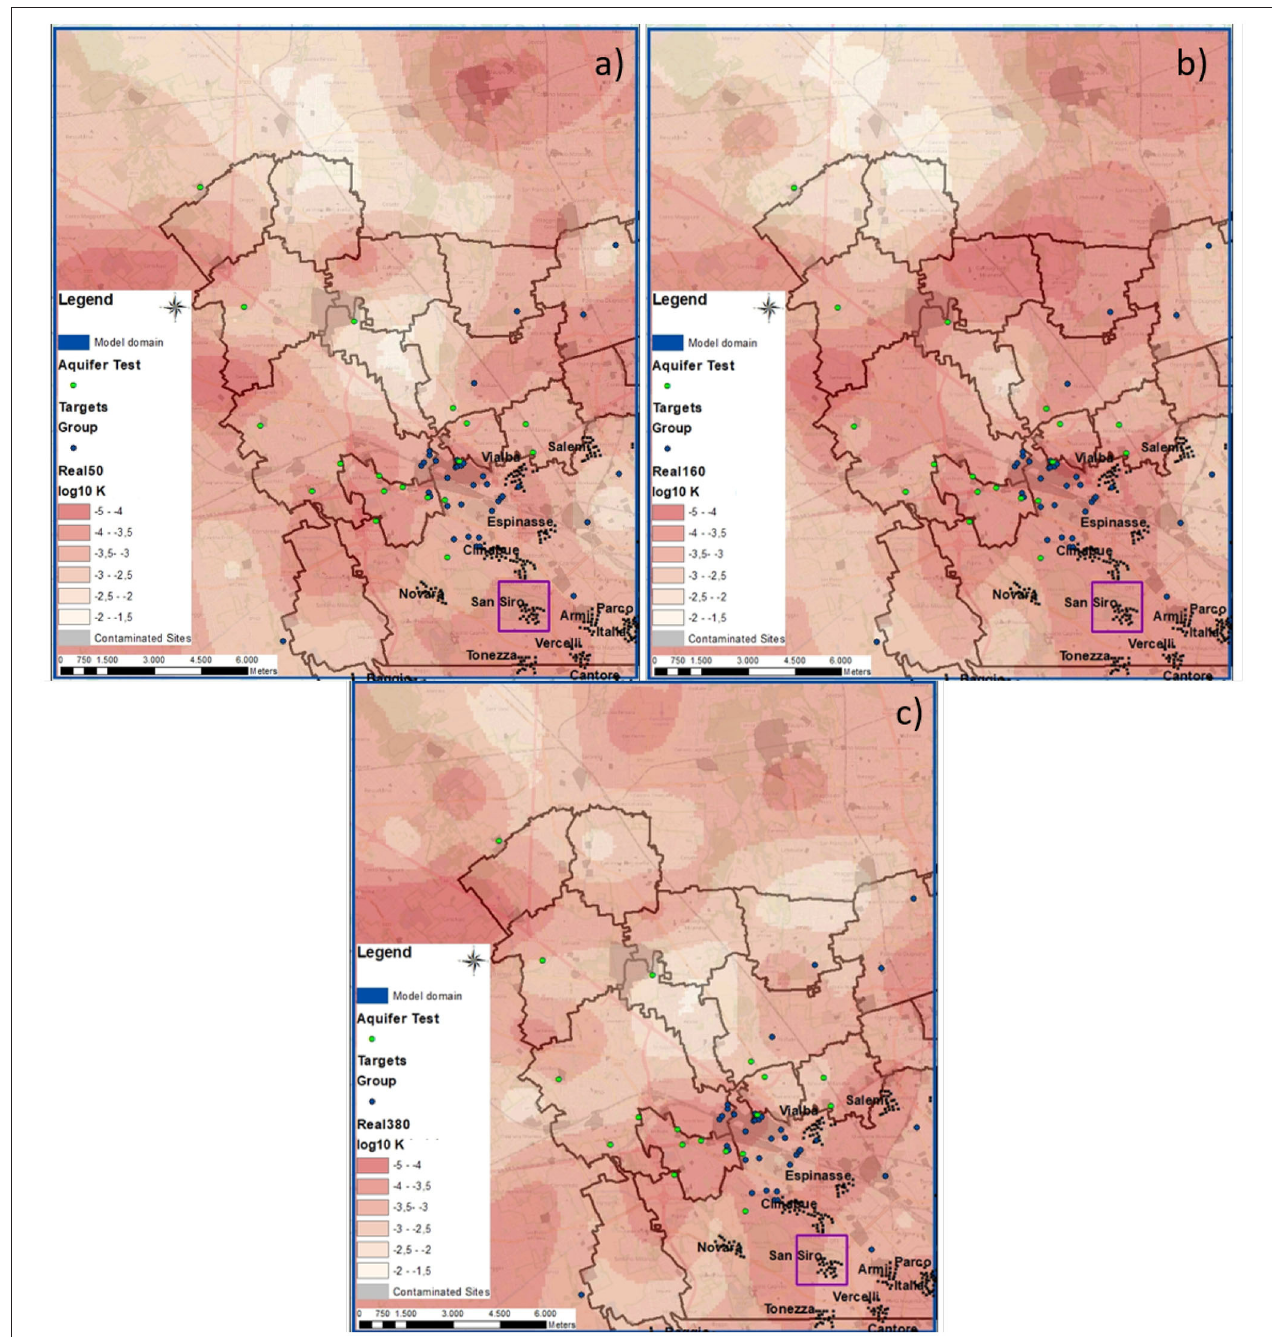
FIGURE 6 | K distribution for Aquifer A for three randomly selected parameter realizations (a–c) . The K values are shown as log10 values, where white and red areas show higher and lower K, respectively. Blue dots represent the head targets and green dots represent the aquifer tests.